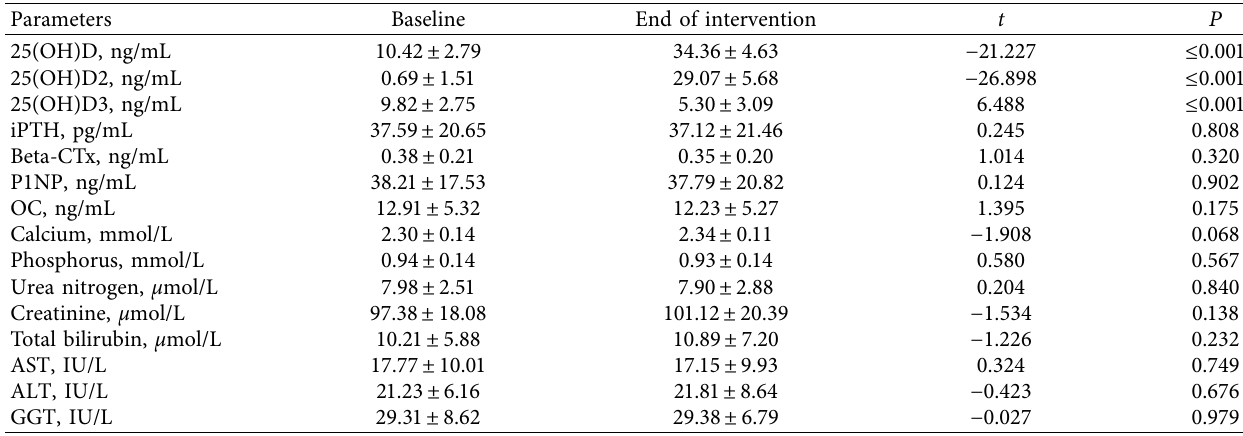
Table 2: Changes in serum levels of 25(OH)D2, 25(OH)D3, iPTH, BTMs, and biochemical parameters after intervention.